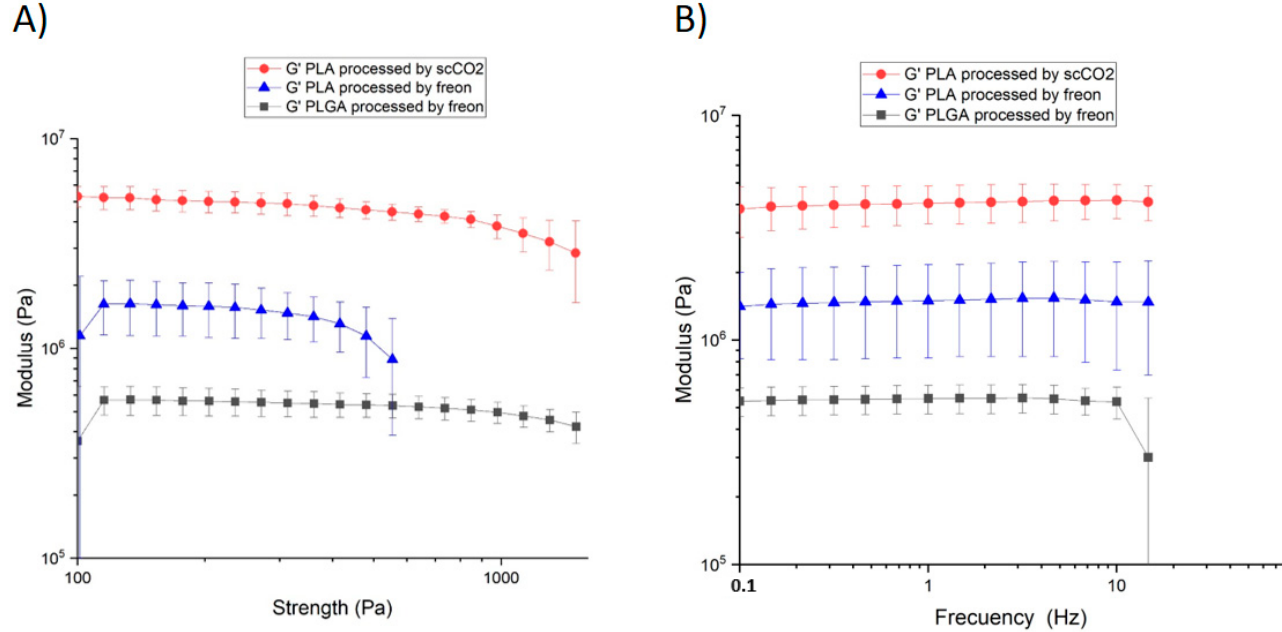
Figure 5. ( A ) Strain and ( B ) frequency sweeps of PLA processed with Freon R134a (blue triangles) or scCO 2 (red dots), as well as PLGA processed with Freon R134a (grey squares).